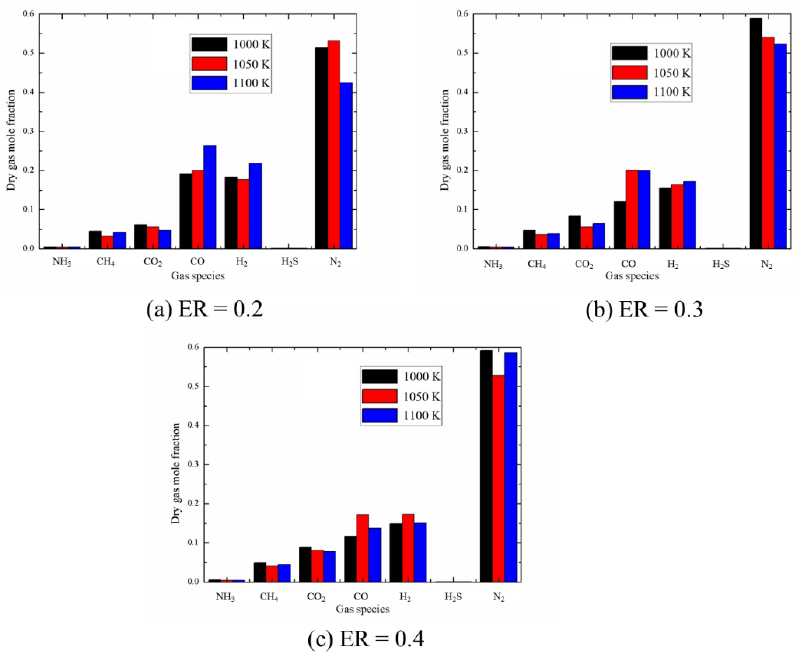
Figure 7. Molar concentrations of syngas components at different initial bed temperatures (ER = 0.2).